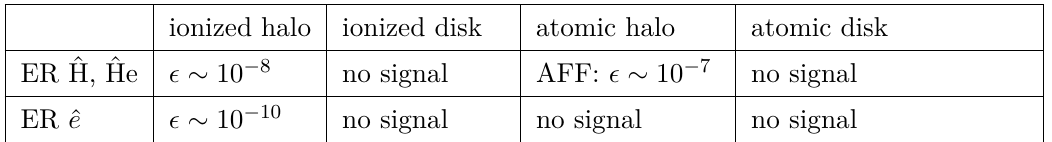
1% for all cases. Limits (cid:12) ∼